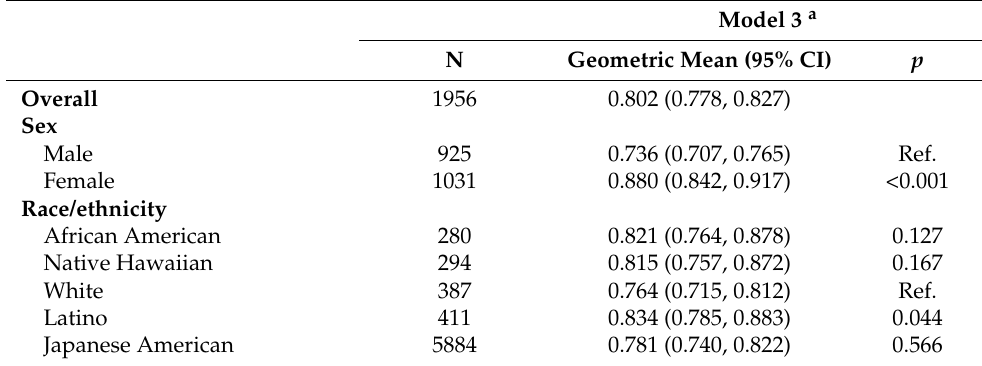
a Model 3: Model 2 (adjusted for self-reported race/ethnicity [for overall and sex specific models], sex (for overall and race/ethnicity specific models], age at urine collection, creatinine (natural log), maximum education attainment level, urinary total nicotine equivalents (TNE) and smoking duration [years]) further adjusted for occupational cadmium exposure categories. p when compared to